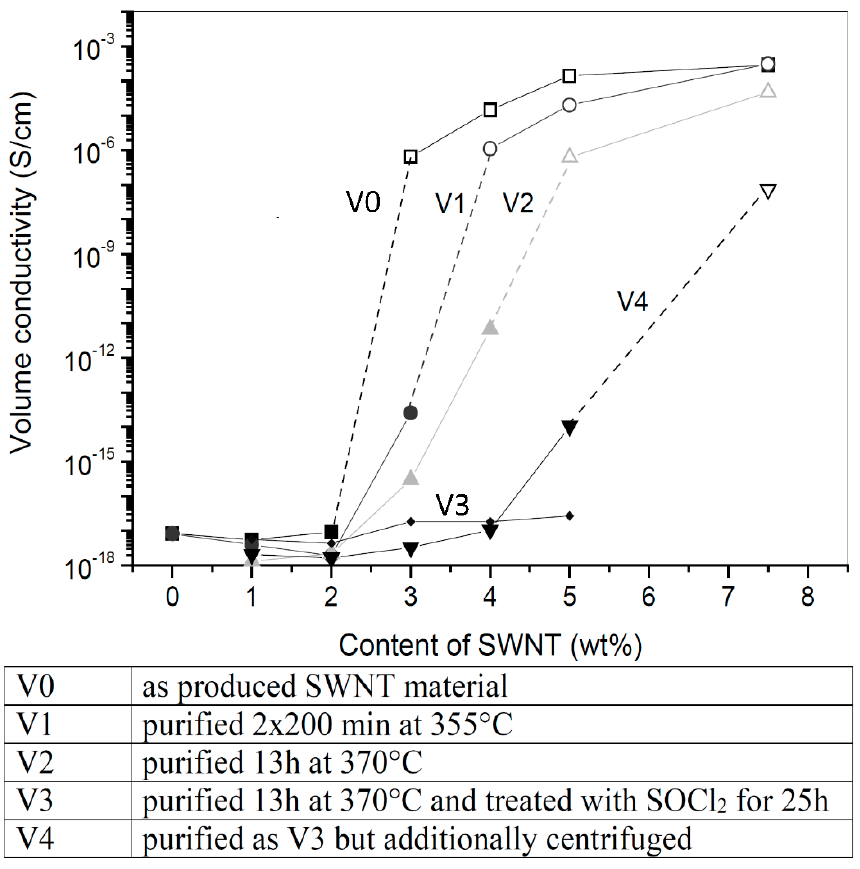
Figure 26. Conductivity versus Single Wall Nanotube (SWNT) concentration for melt-mixed SWNT/PC composites at different levels of SWCNT purity. Modified from [73].